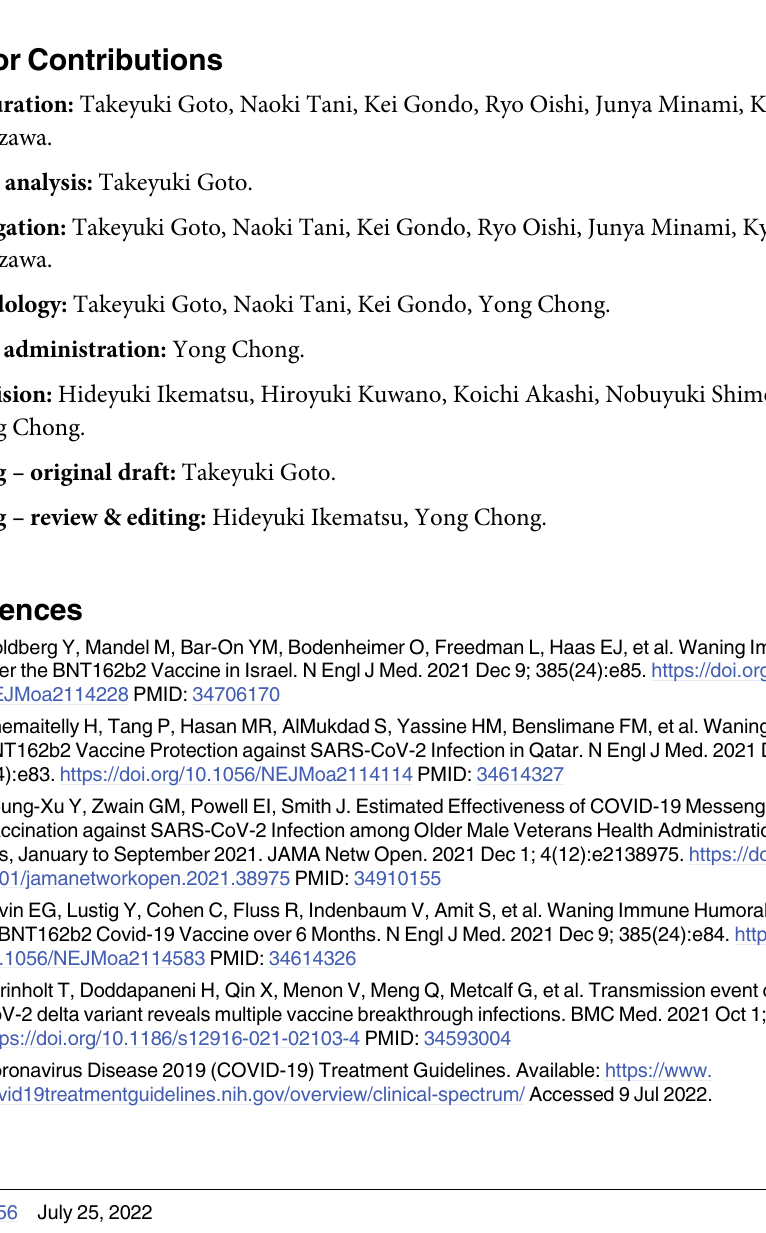
line was drawn to connect the points. A line with three or more sampling points was based on the results of linear regression. The triangle shows the timing of onset for each. The predicted peak period, between 21 and 30 days after the second vaccination, is highlighted in yellow. S3 Fig. Location on the phylogenetic tree of the samples from SARS-CoV-2 infected per- sons. All samples (Blue box) were included in a subclade of the delta (B.1.617.2) variant (Red shading). The phylogenetic tree was obtained from worldwide data on Nextclade in September of 2021.